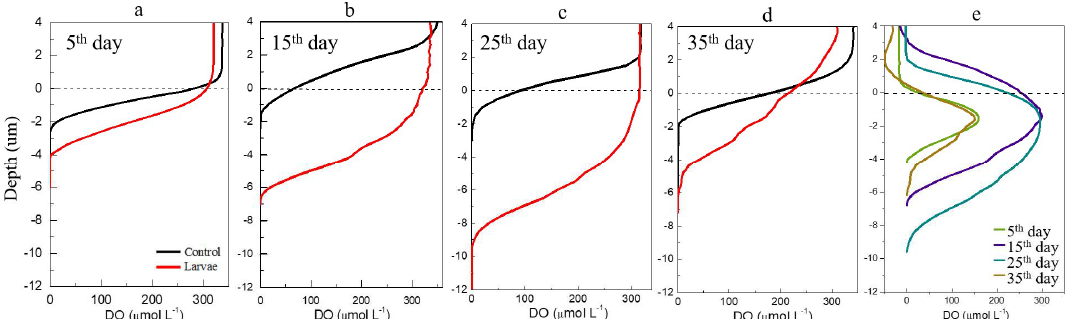
Figure 1. DO profiles in sediment cores of the control and the Chironomid larvae treatment. The horizontal dashed line at zero indicates the sediment–water interface (SWI); over the line indicates overlying water; under the line indicates sediments. (e) DO changes in treatment minus changes in control on the 5th ( a ), 15th ( b ), 25th ( c ) and 35th ( d ) day, respectively.